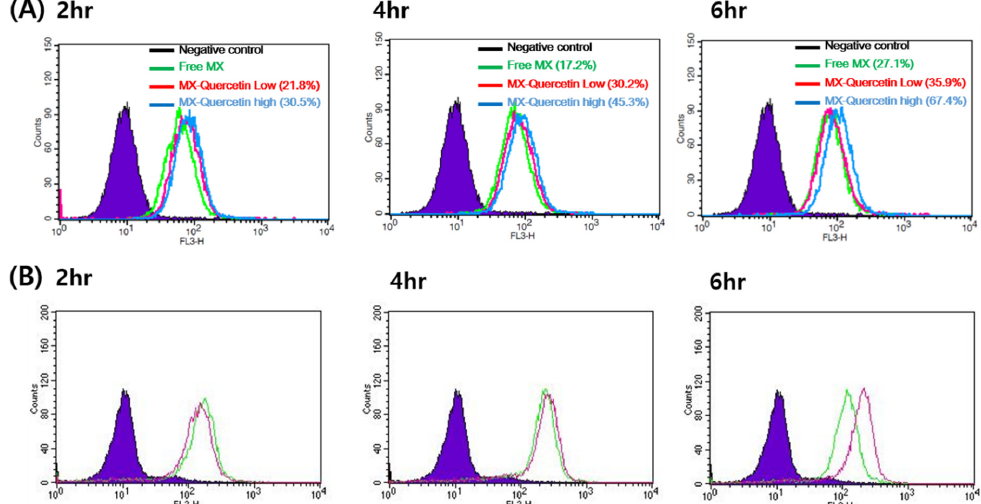
Figure 2. Representative histogram of mitoxantrone (MX) uptake in HeLa cells. ( A ) Flow cytometry measurement of MX fluorescence in HeLa cells incubated with MX alone (green line) or MX with 1 (red line) or 100 µ M quercetin (blue line) for 2, 4, and 6 h. ( B ) Flow cytometry measurement of MX fluorescence in HeLa cells incubated with MX alone (green) or MX with 1 µ M Ko143, a specific breast cancer resistance protein (BCRP) inhibitor (purple line), for 2, 4, and 6 h.